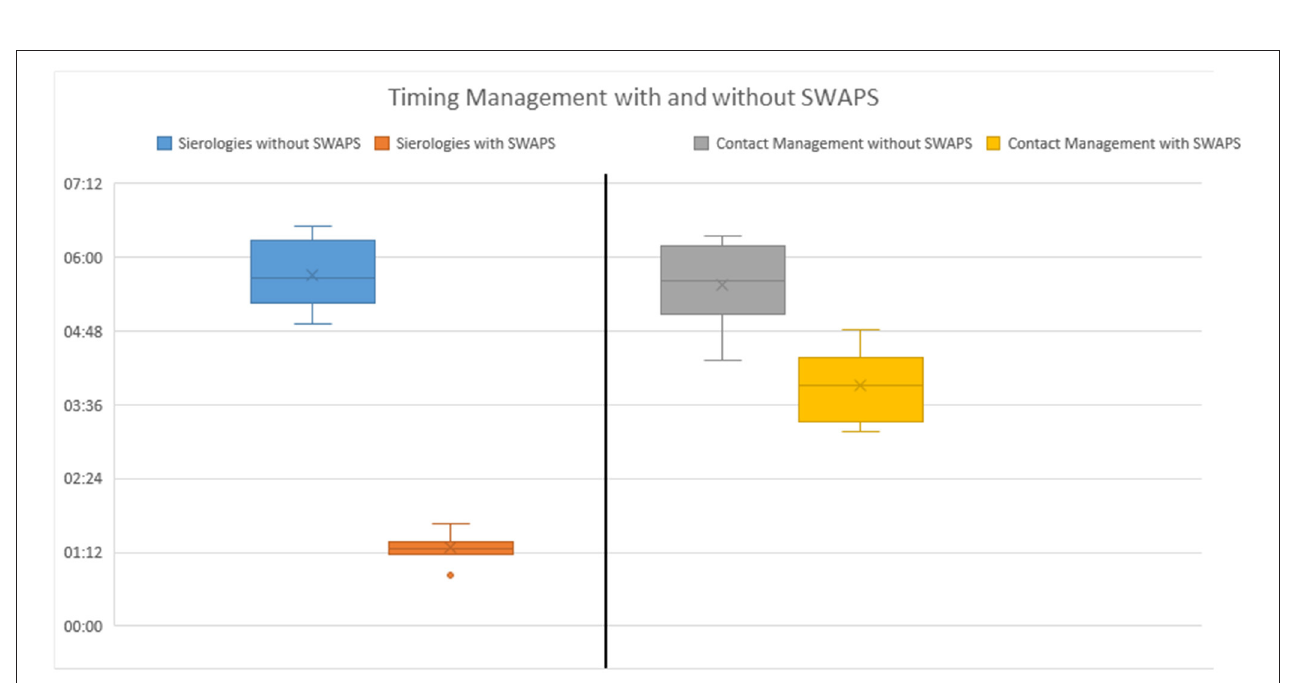
FIGURE 3 | Timing management with and without